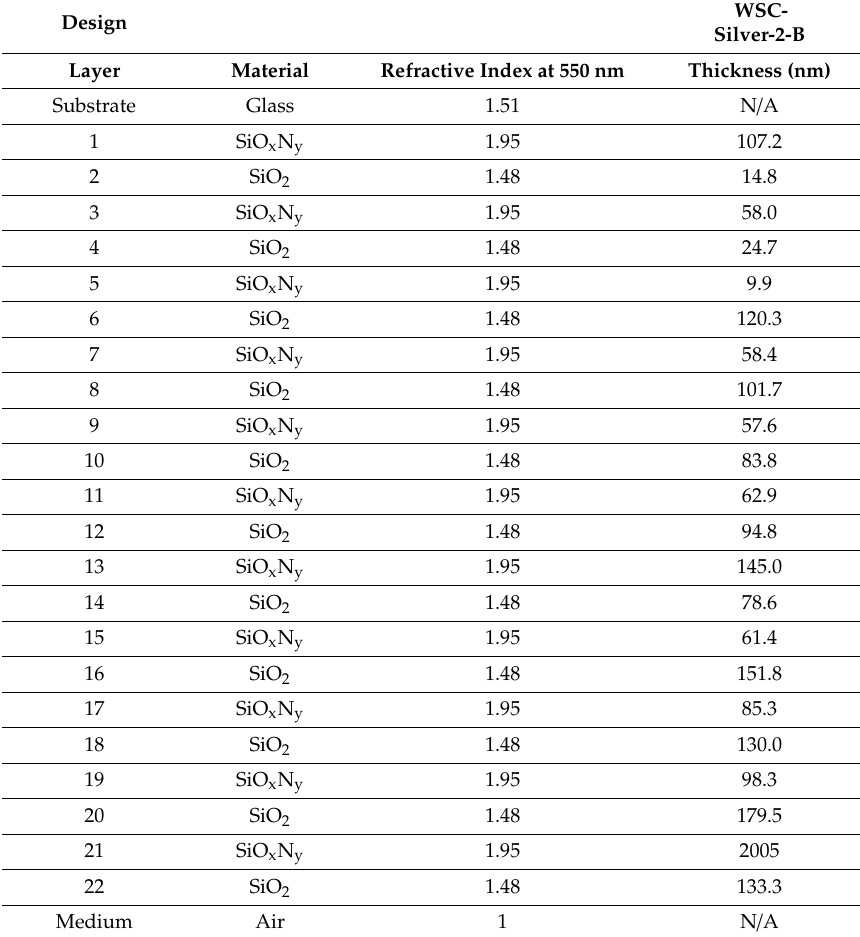
Table A2. Summary of detailed coated designs for Design Strategy 2 sample WSC–Silver–2–B.